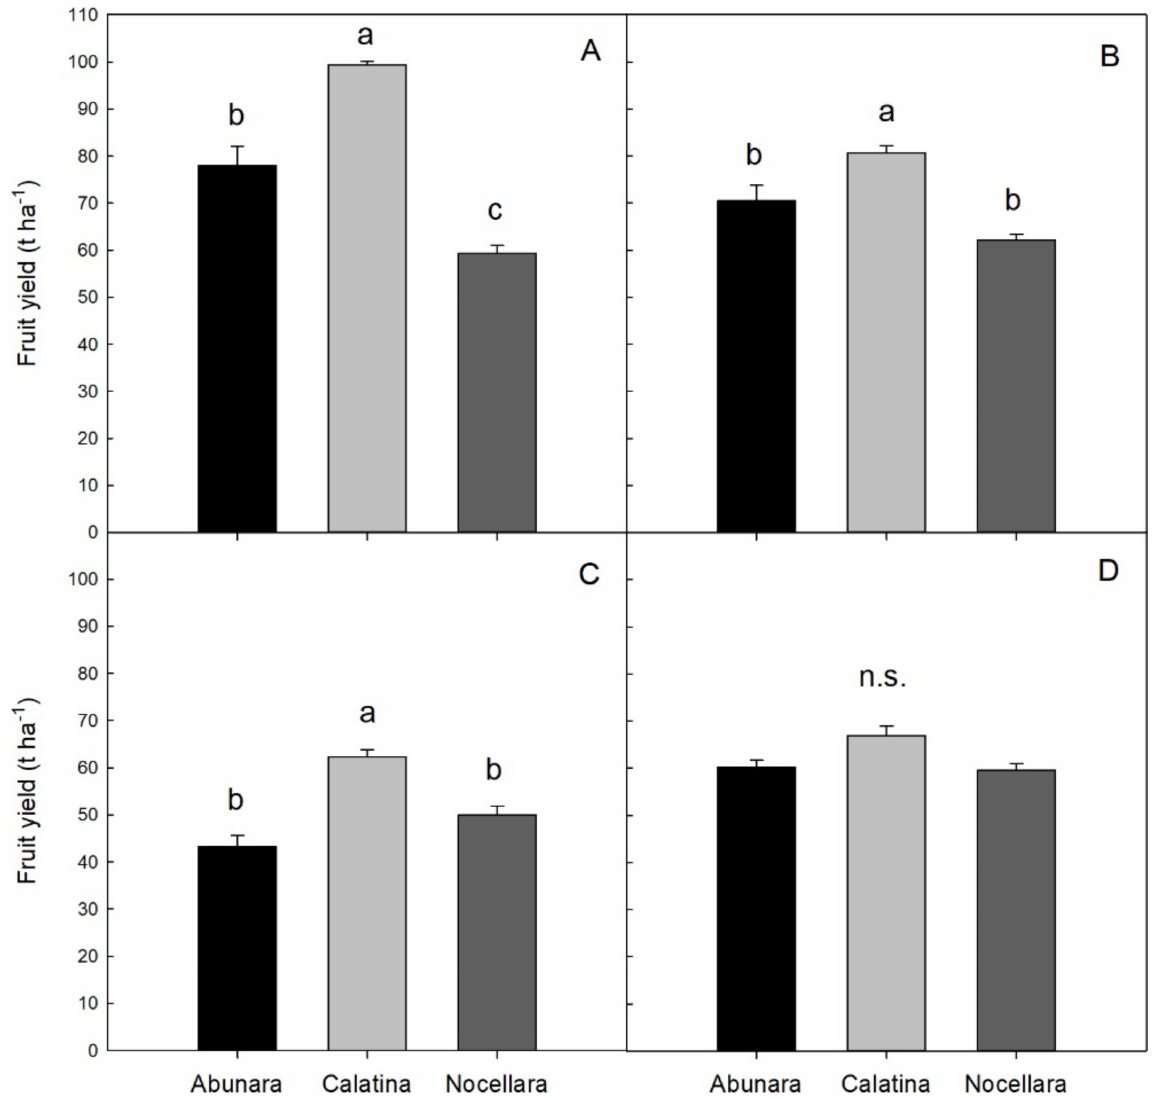
Figure 6. Cumulated fruit yield per hectare across the seven years of trial for ‘Abunara’, ‘Calatina’, and ‘Nocellara del Belice’ olive trees grown as central leaders at 2 × 5 m (CLx2, ( A )), free palmette at 3 × 5 m (FPx3, ( B )), globe vase at 4 × 5 m (GVx4, ( C )), and polyconic vase at 5 × 5 m (PVx5, ( D )). Error bars represent standard errors of the means. Mean separation by Tukey’s honestly significant difference (HSD, p < 0.05). Different letters indicate significant differences among cultivars and within each planting system; n.s.,